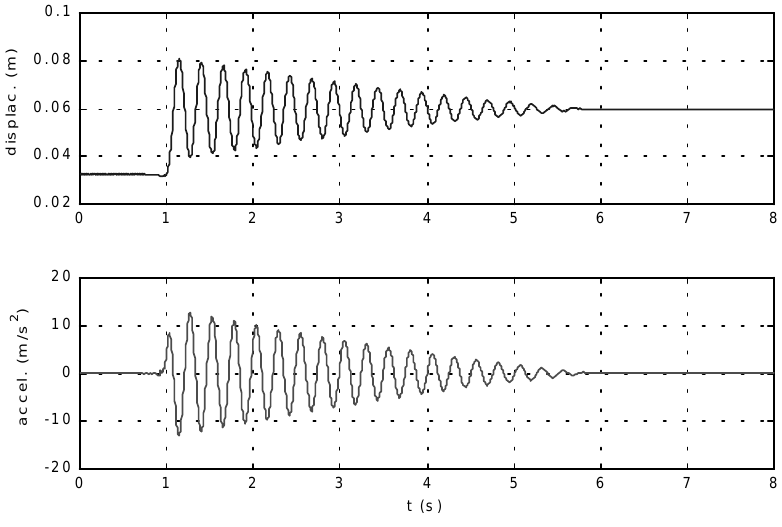
Fig. 2. Example of recorded displacement and